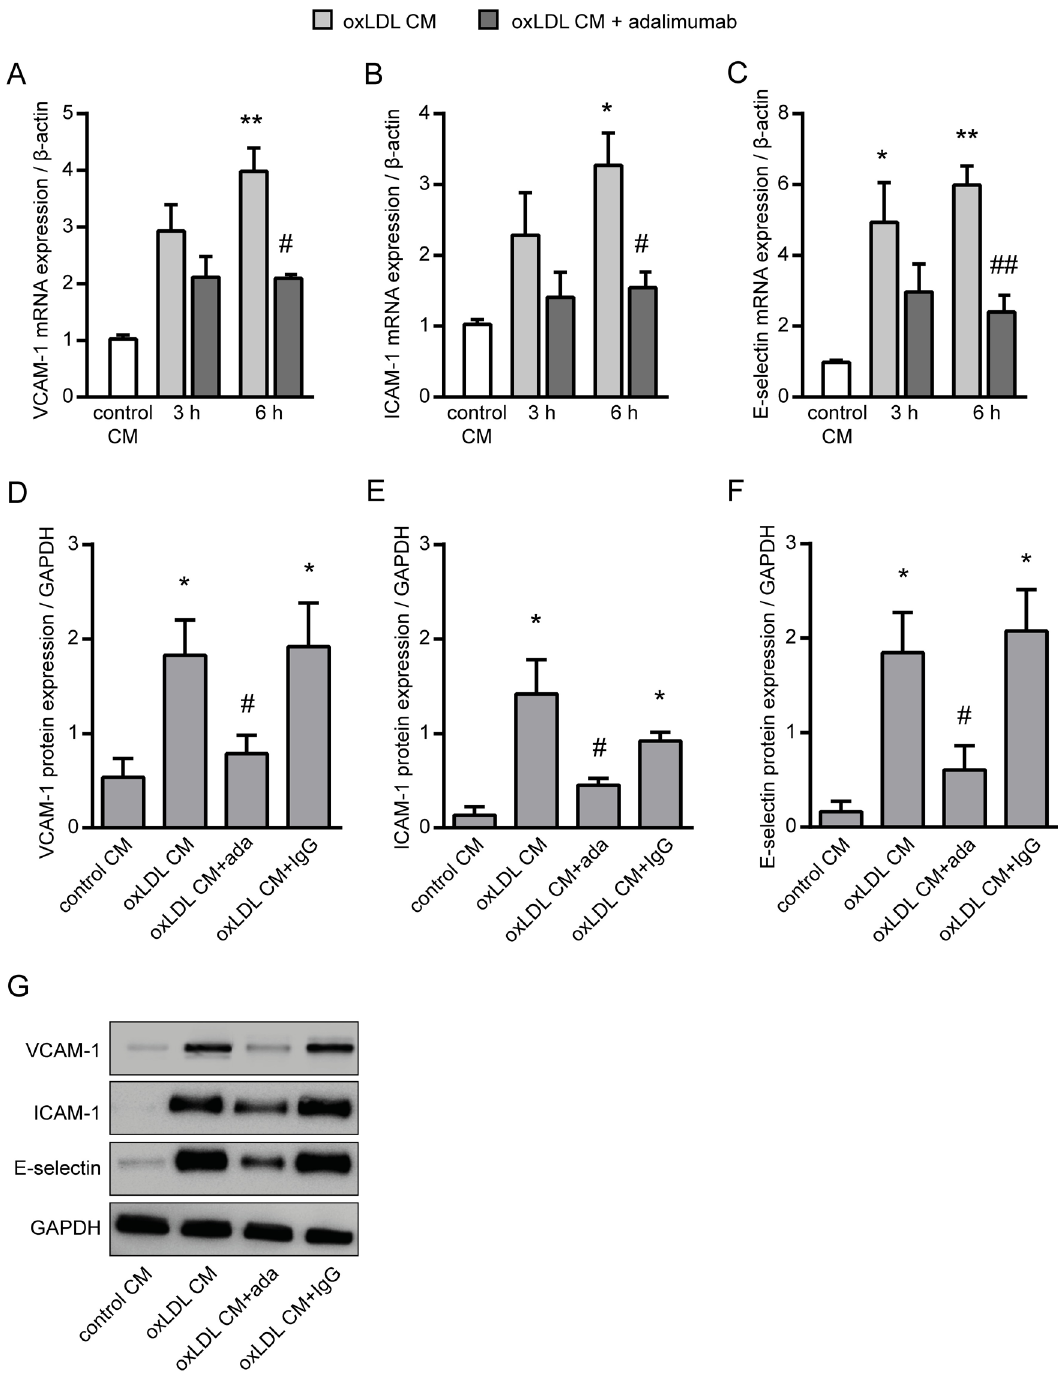
Fig 3. Effect of TNF- α inhibition with adalimumab on endothelial adhesion molecules. mRNA expression of the adhesion molecules (A) VCAM-1, (B) ICAM-1 and (C) E-selectin in HUVECs following 6 hours of incubation with conditioned media from oxLDL-stimulated THP-1 cells (oxLDL CM) with or without adalimumab (ada, 1 μ g/mL) was determined by real time PCR. Conditioned medium from unstimulated THP-1 macrophages were used as control (control CM). Protein expression of the adhesion molecules (D) VCAM-1, (E) ICAM-1 and (F) E-selectin in HUVECs following 6 hours of incubation with conditioned media from oxLDL-stimulated THP-1 cells (oxLDL CM) with or without adalimumab was determined by western blot. (G) Representative blots are shown. Conditioned medium from unstimulated THP-1 macrophages (control CM) and IgG isotype (1 μ g/mL) were used as control. GAPDH was used as loading control for